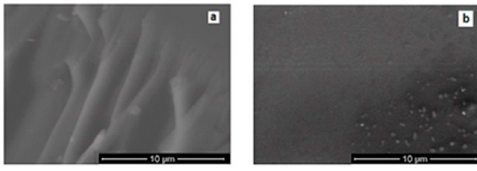
Figure 1. SEM images after acetic acid corrosion ( a ) uncoated glass and ( b ) silica coated glass. The surface of model glass similar to ancient glass was damaged by acetic acid. The silica coating protected the glass against corrosion from acetic